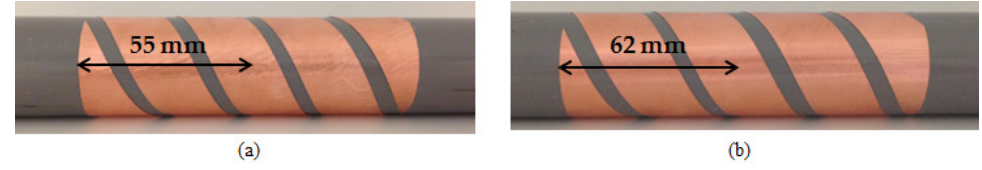
Figure 10. Helical capacitance sensor for: ( a ) Air-water; ( b ) Oil-water. Pitch size is shown for each design.